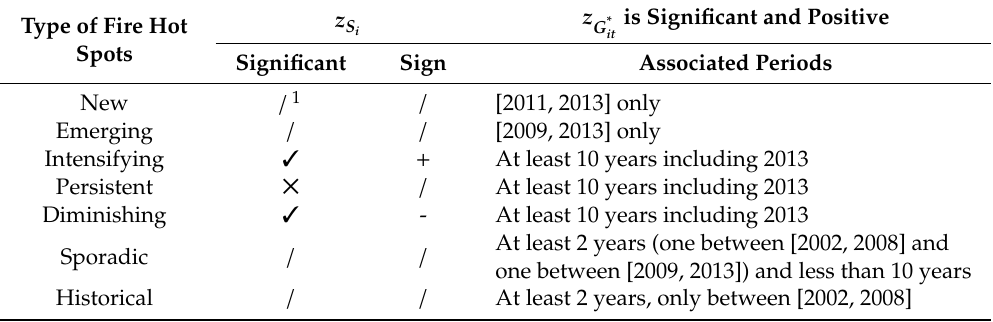
Table 1. Characterizing the bin time series at location i in relation to urban fire